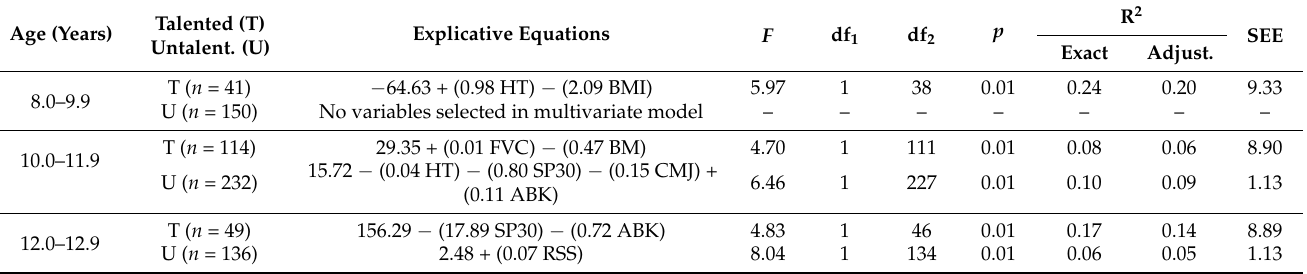
Table 4. Stepwise multiple linear regression analysis by chronological age groups in talented and untalented Chinese children soccer